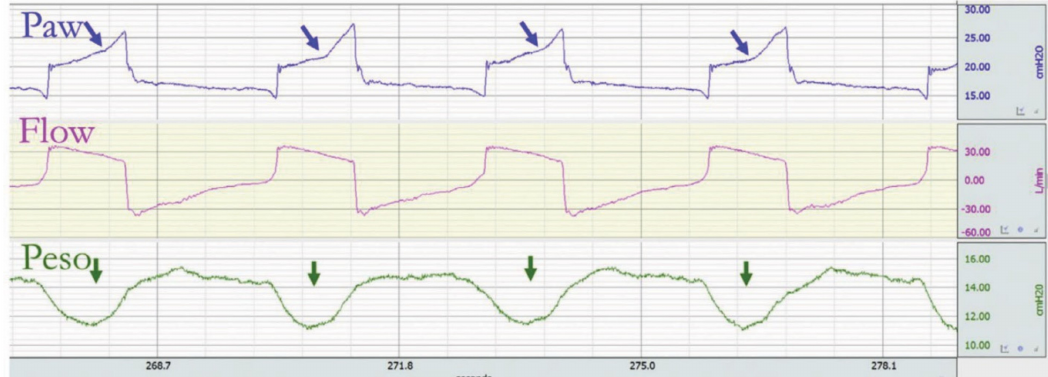
Figure 3. Example of a tracing with relative flow starvation. The ventilator is in a volume assist–control mode with decelerating flow. The flow delivered by the ventilator does not meet the patient’s need. During the inspiration phase, there is a concave deflection of the airway pressure (Paw) (blue arrow), whereas the esophageal pressure (Peso) displays a negative deflection indicating patient’s effort (green arrow). Reprinted with permission from